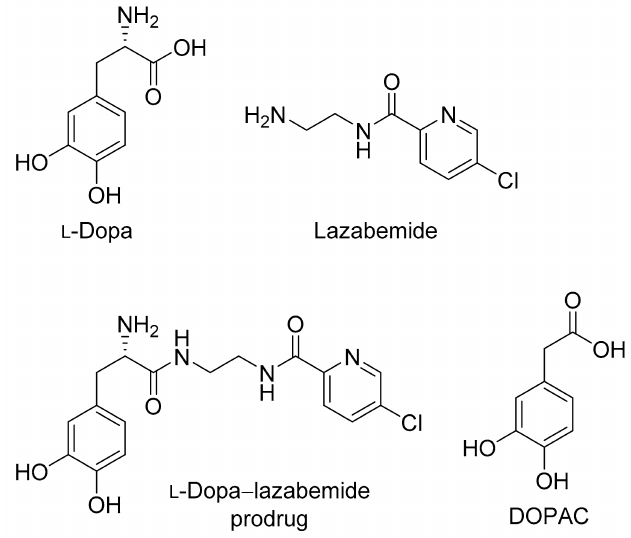
Figure 1. The structures of L -dopa, lazabemide and the L -dopa–lazabemide prodrug. The structure of DOPAC, a major metabolite of dopamine, is also